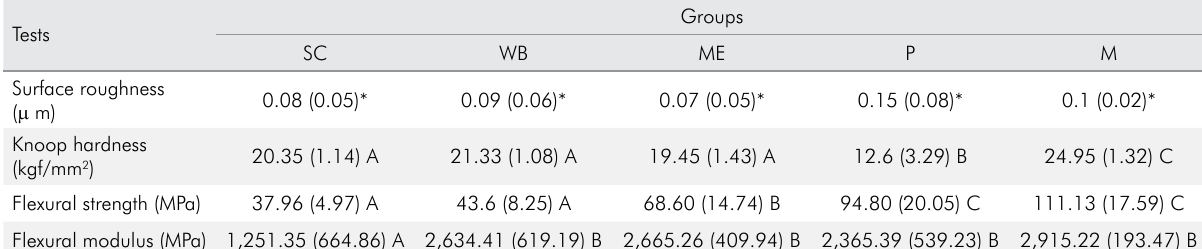
Table 3. The mean values (standard deviation) and Tukey test results for the tests showed a statistically significant difference in the one-way